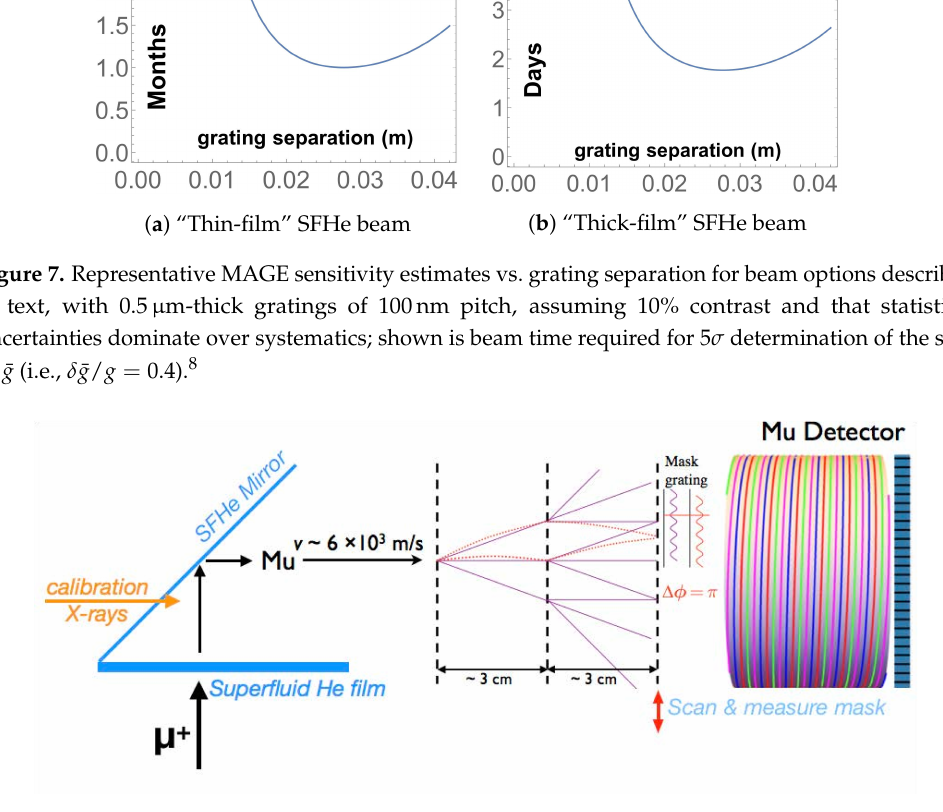
Figure 8. MAGE concept